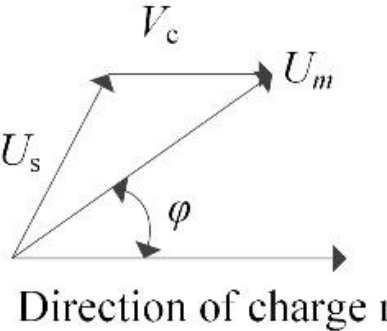
→ U m is the shock wave velocity at distance r and angle ϕ , where velocity for a stationary charge and ϕ is the angle from the line of flight for a moving charge (referred to as the center of the shock wave).